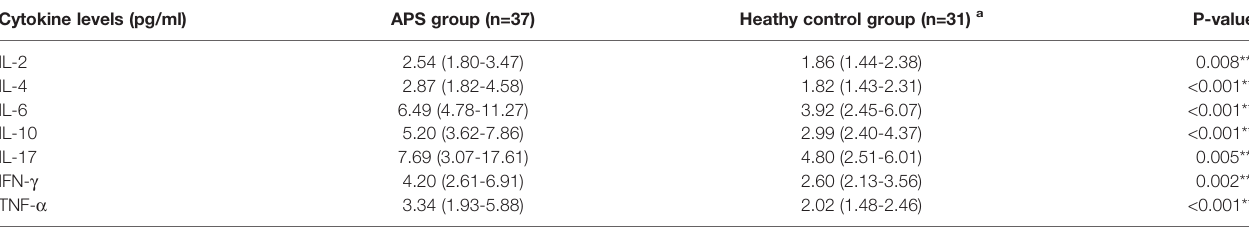
TABLE 2 | Cytokine levels (pg/ml) in APS group and heathy control